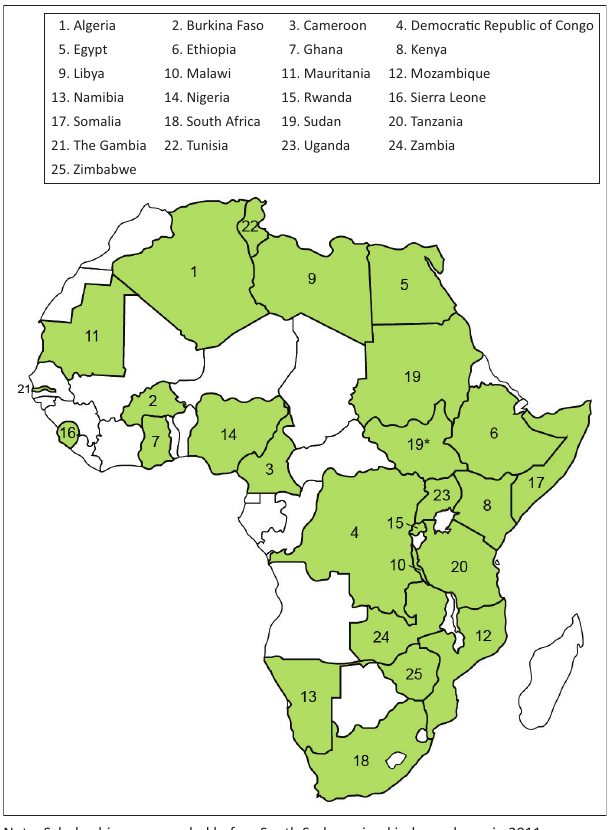
FIGURE 1: A total of 211 next-generation African veterinary parasitologists from 25 African countries submitted applications for the World Association for the Advancement of Veterinary Parasitology African Foundation Scholarships. Eighty scholarships were awarded to applicants from 18 countries (number of applicants): Algeria (2), Burkina Faso (1), Egypt (1), Ethiopia (2), Kenya (16), Mozambique (1), Nigeria (10), Sierra Leone (1), Somalia (1), South Africa (26), South Sudan (1), Sudan (3), Tanzania (4), The Gambia (1), Tunisia (2), Uganda (2), Zambia (5) and Zimbabwe